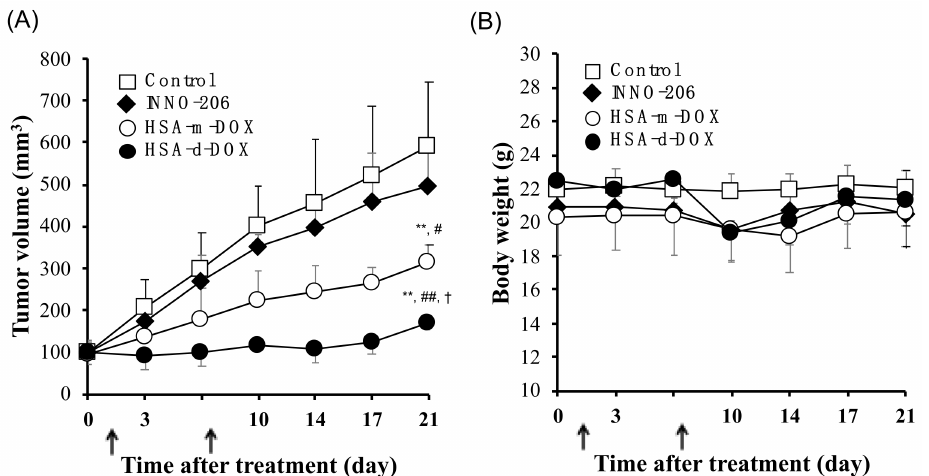
Figure 5. The antitumor activity of HSA-d-DOX in SUIT2 ectopic tumor bearing mice. ( A ) The tumor volume and ( B ) body weight were measured in SUIT2 ectopic tumor bearing mice at each of the selected time points. The mice were IV injected with PBS, INNO-206 (8.0 mg (DOX)/kg), HSA-m-DOX (8.0 mg (DOX)/kg) or HSA-d-DOX (8.0 mg (DOX)/kg) at each of the selected time points. The arrows indicate days of treatment. Data are averages ± standard deviation ( n = 4). ** p < 0.01 vs. control, # p < 0.05, ## p < 0.01 vs. INNO-206, † p < 0.05 vs. HSA-m-DOX.